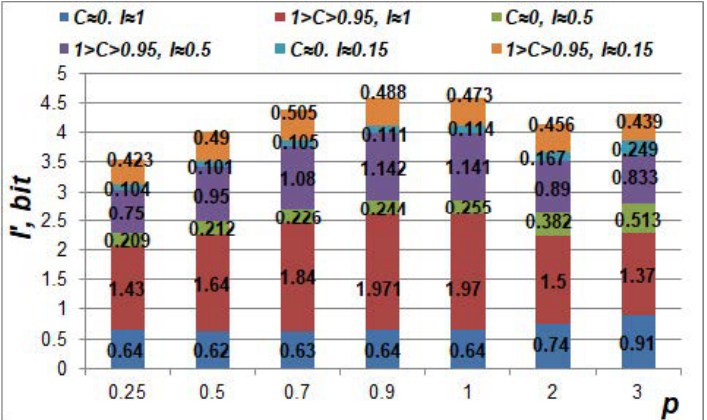
Figure 8. Average informativeness of meta-features I ’ generated by the mapping in (12). The described regularities are valid when features have a normal distribution. For other distribution laws, evaluations were not